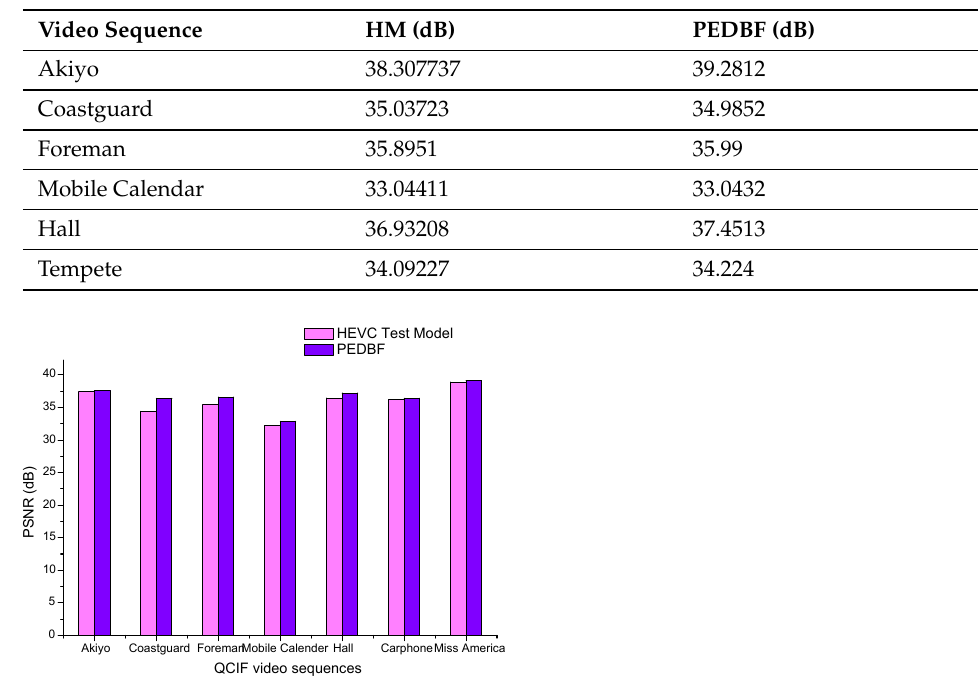
Figure 17. Comparison of PSNR with HM for QCIF video sequences using QP = 32.